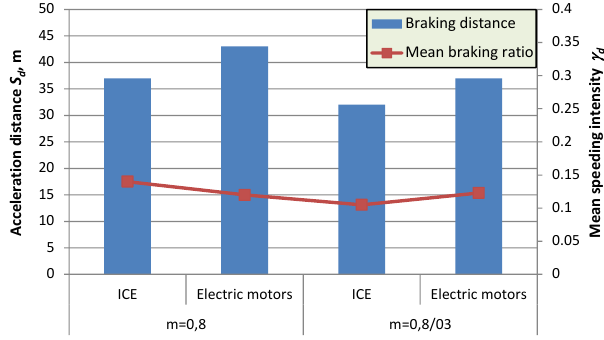
Fig. 14. Comparison speeding the vehicle in an attempt to drive straight ahead on a road with high homogeneous and different adhesion coefficient under the wheels of the left and right side [own